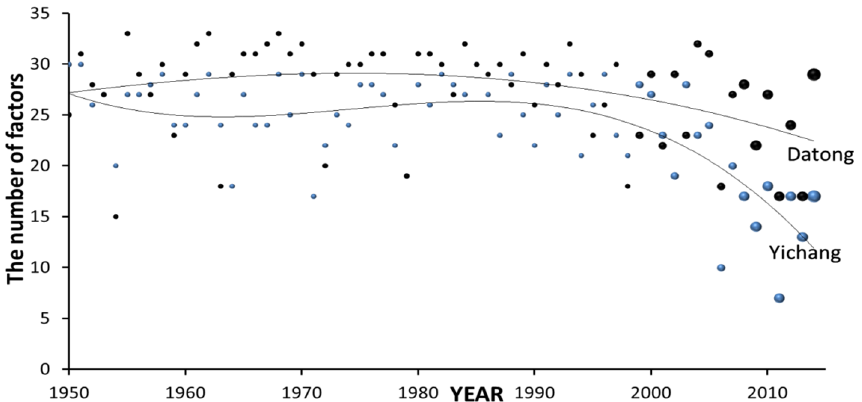
Figure 6. The number of IHA factors that fall into the normal range.